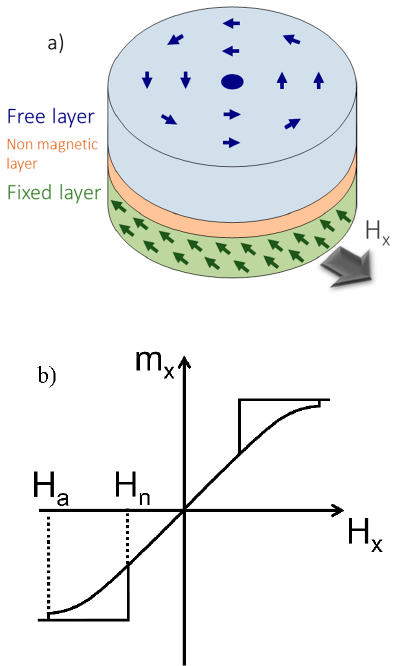
Figure 1. Magnetic vortex characteristics. ( a ) Flux closure state of the magnetic vortex within the free layer of an employed giant magnetoresistance (GMR) stack. ( b ) Characteristic magnetic hysteresis loop of a magnetic vortex with an annihilation field H a and a nucleation field H n . Magnetic vortices arise in micron-sized, nanometer-thick, circular ferromagnetic disks, where the lateral extension is much larger than the thickness of the layer. In the absence of a magnetic field, flux closure state with an out of plane magnetization in the center of the disk (vortex core) [12]. In the